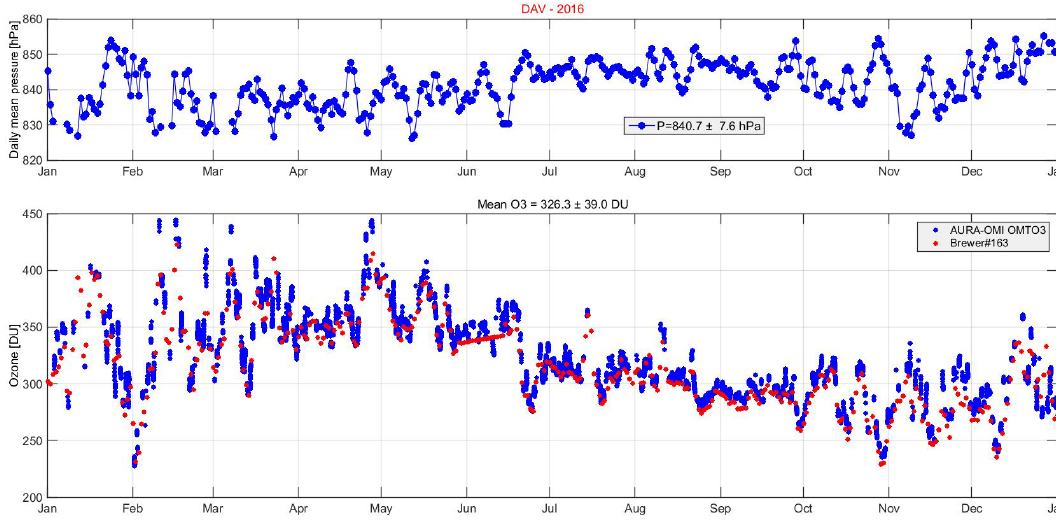
Figure 7. (a) Daily mean pressure during 2016 at Davos, Switzerland. (b) Brewer and OMI ozone